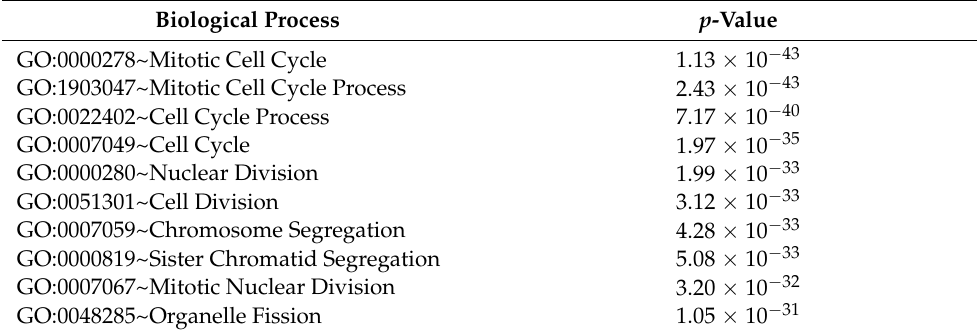
Table 2. Top 10 significantly enriched biological processes along with their respective p -values.